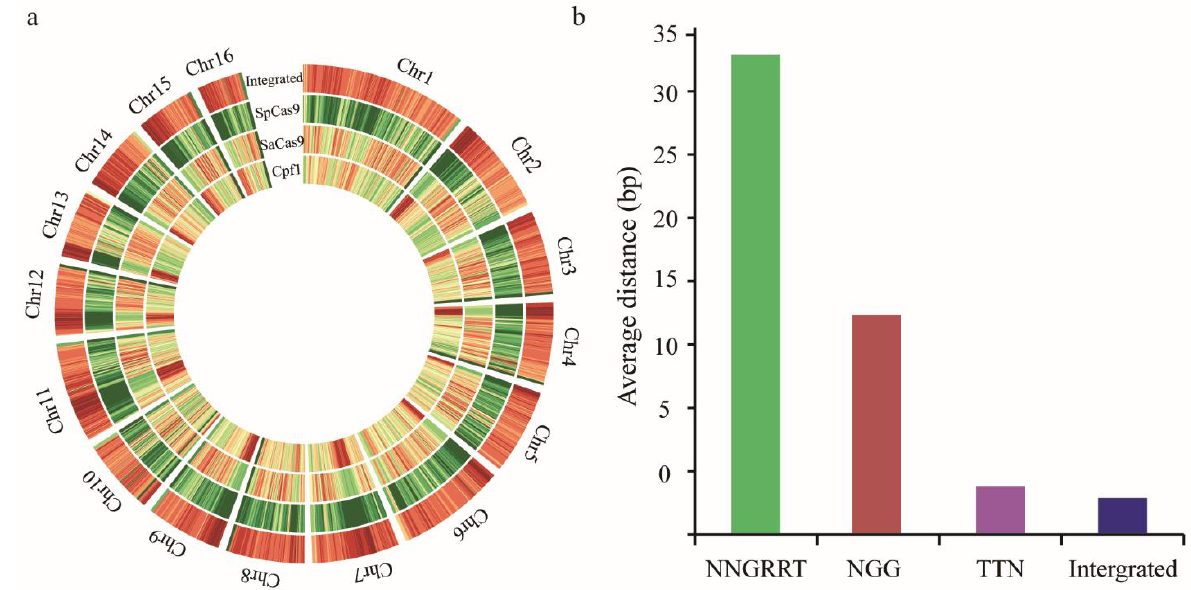
Figure 2. Bioinformatics analysis of CRISPR targeting sites on A. mellifera chromosome: ( a ) distribution of different target sites’ position on a chromosome. The red and green colour indicates high density and low density of CRISPR sites, respectively; ( b ) the average distance of two adjacent sites along the whole chromosome.